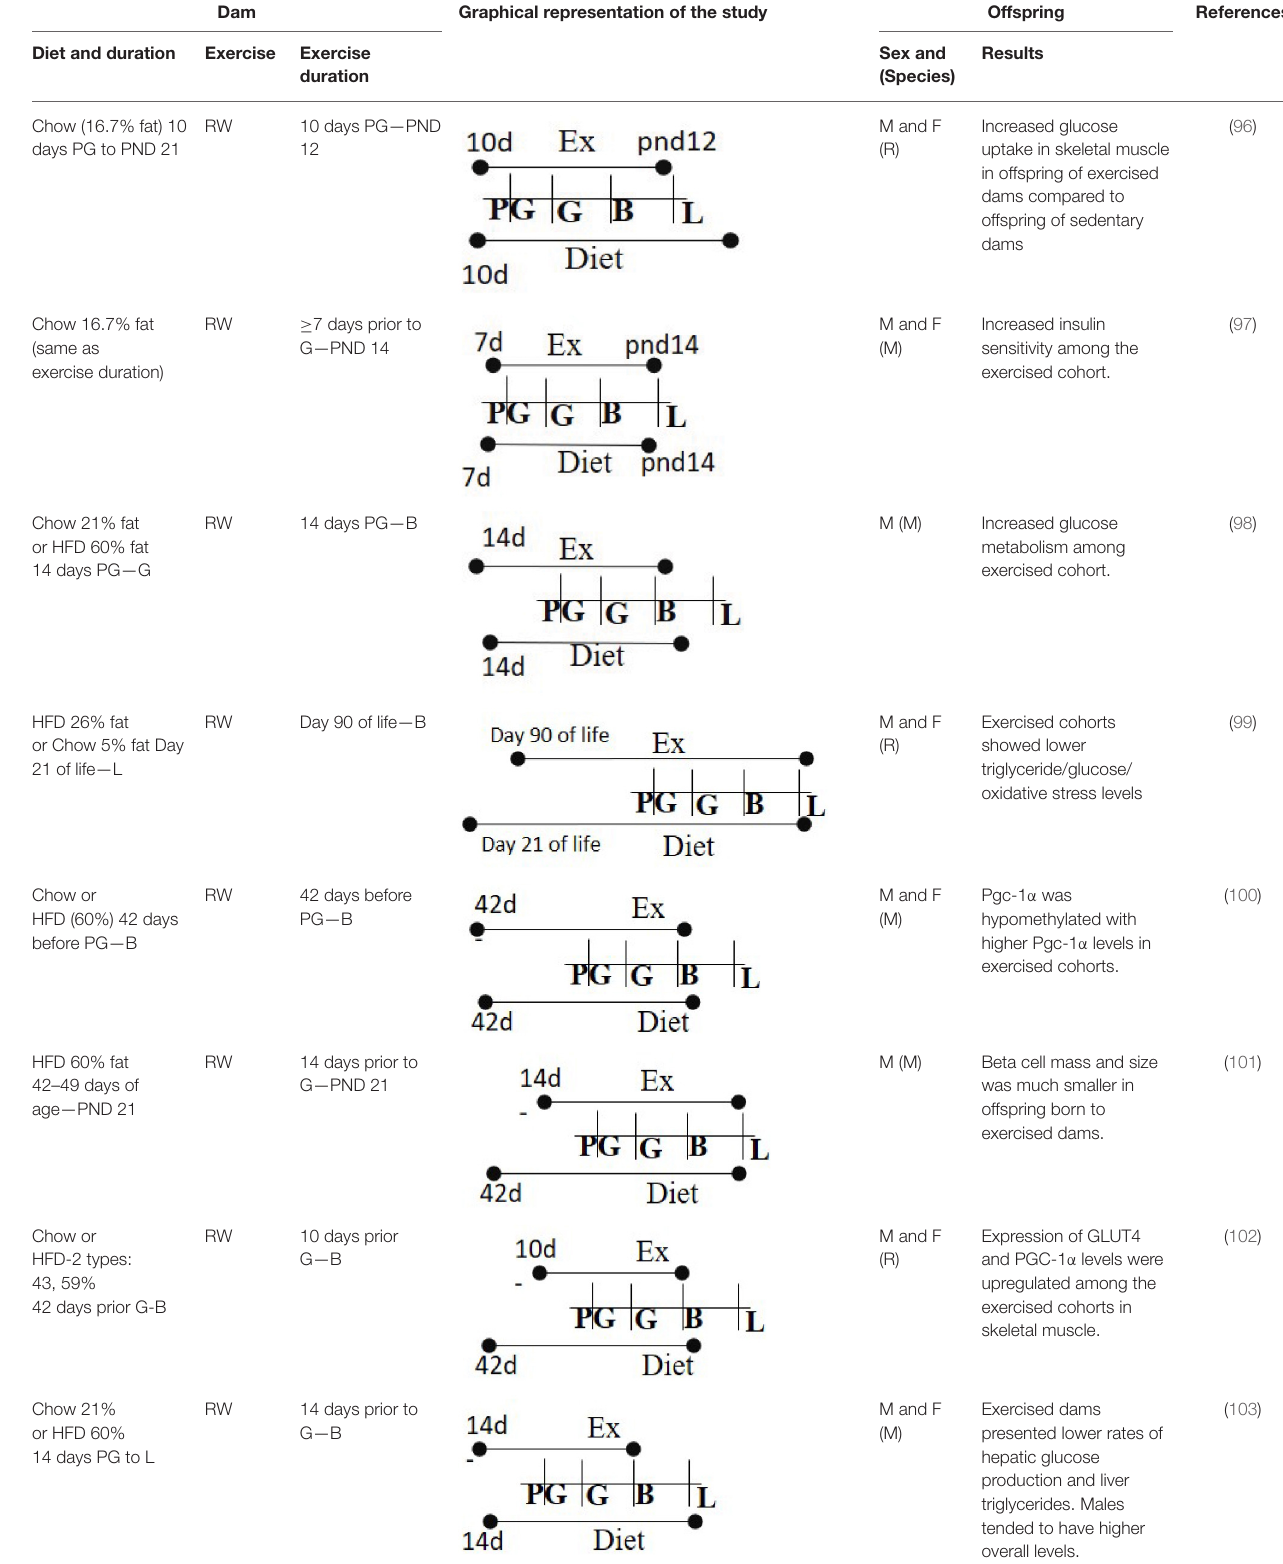
TABLE 1 | List of animal studies analyzing the beneficial effects of physical